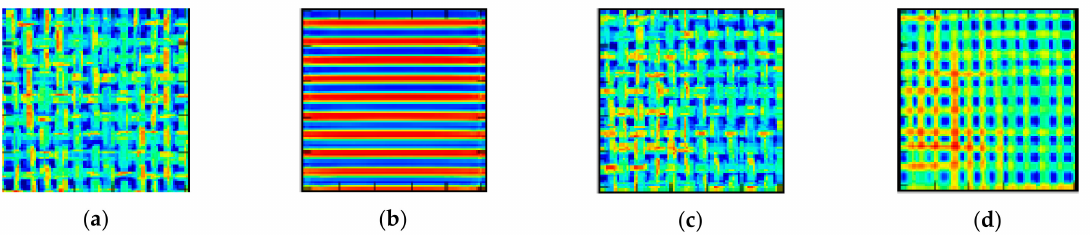
Figure 3. Reconstruction error for a latent layer with 1024 neurons (left, images ( a , b )) and with 2048 neurons (right, images ( c , d